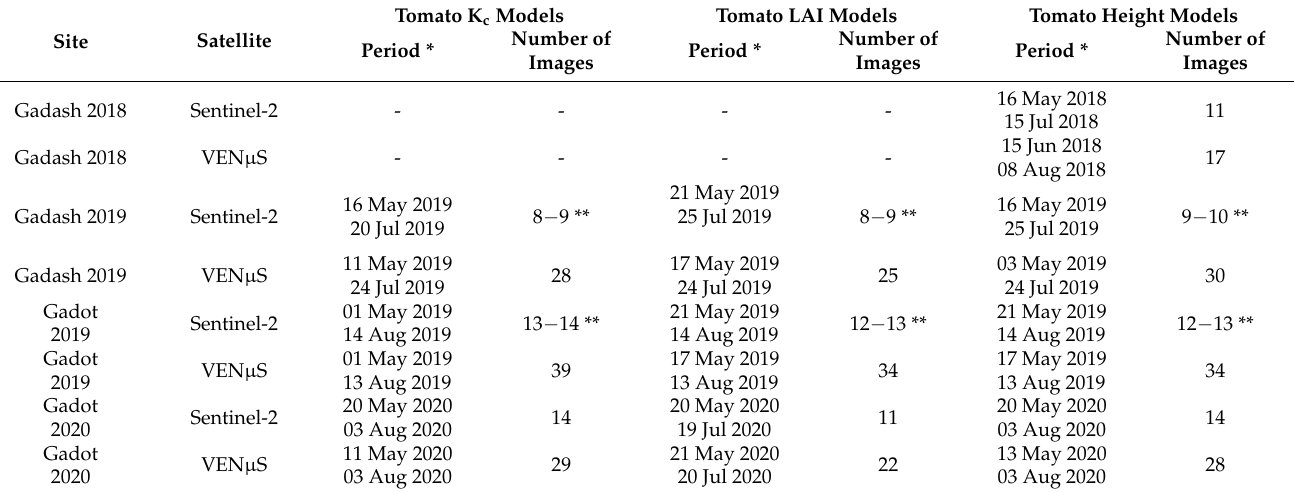
Table 3. Imagery inventory from which processing tomato K c , LAI, and height models were